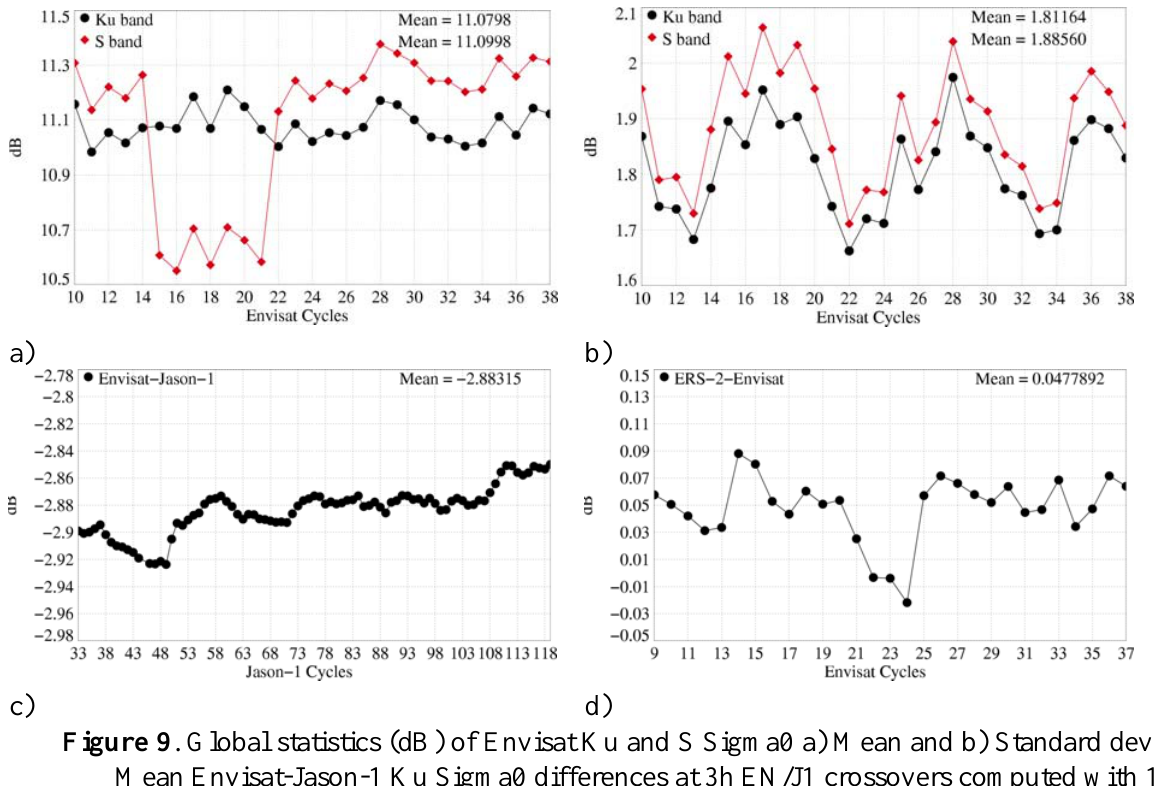
Figure 9 . Global statistics (dB) of Envisat Ku and S Sigma0 a) Mean and b) Standard deviation. c) Mean Envisat-Jason-1 Ku Sigma0 differences at 3h EN/J1 crossovers computed with 120 days running means. d) Mean ERS-2-Envisat Ku Sigma0 collinear differences over the Atlantic